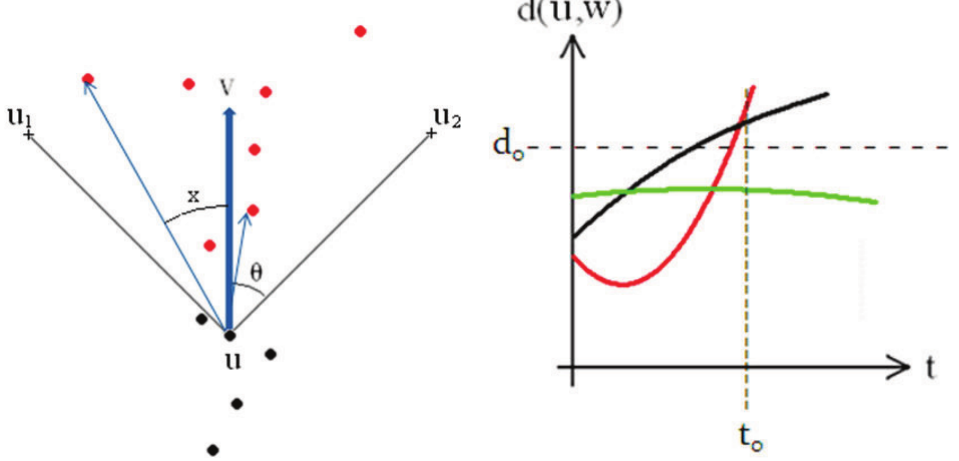
Figure 3. The cone-based scheme ( Left ); the time-slot scheme ( Right ).